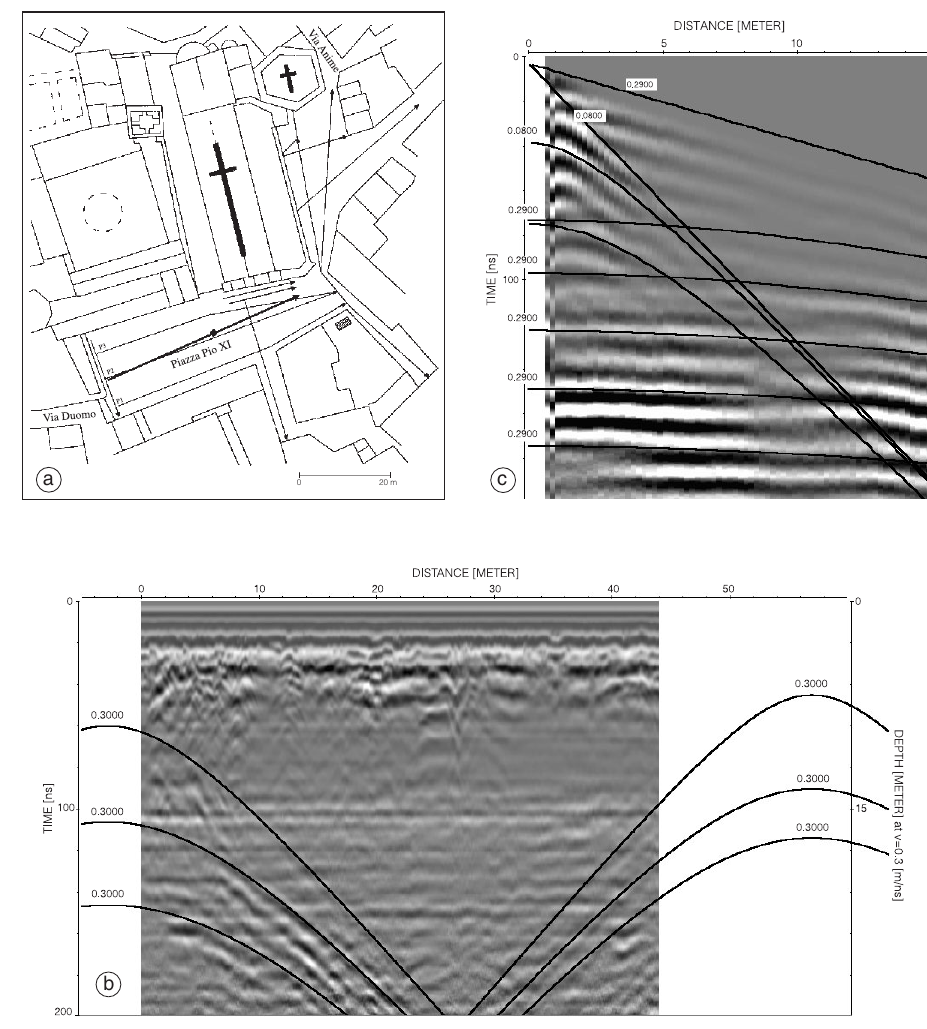
Fig. 4a-c. Example 2: Nardò, Lecce, Italy – Surface-scattering from buildings. a) Location map of the GPR survey; b) radar section relative to the profile evidenced by a heavy line in (a); c) CDP gather centred at the position marked by a dot in